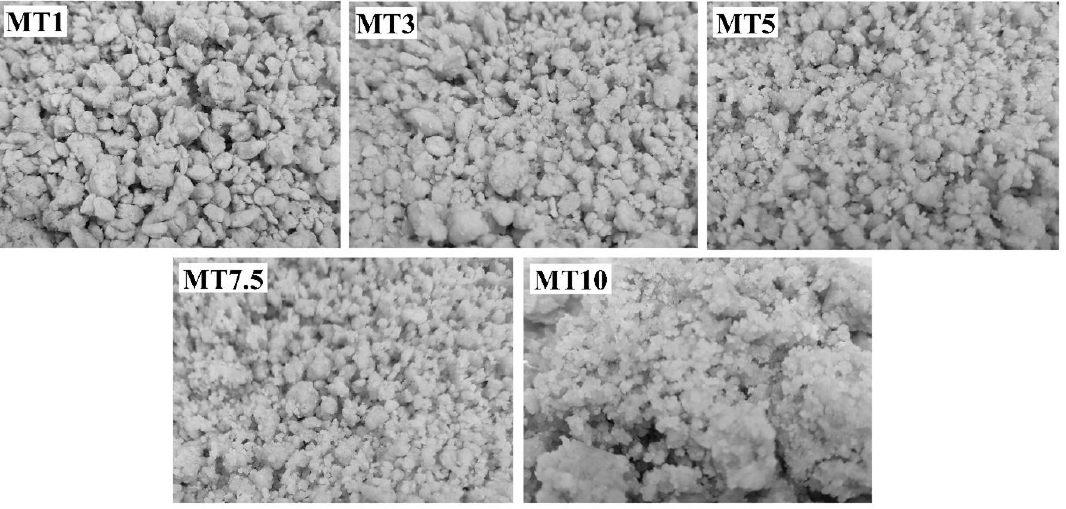
Figure 1. Visual appearance of the dough after